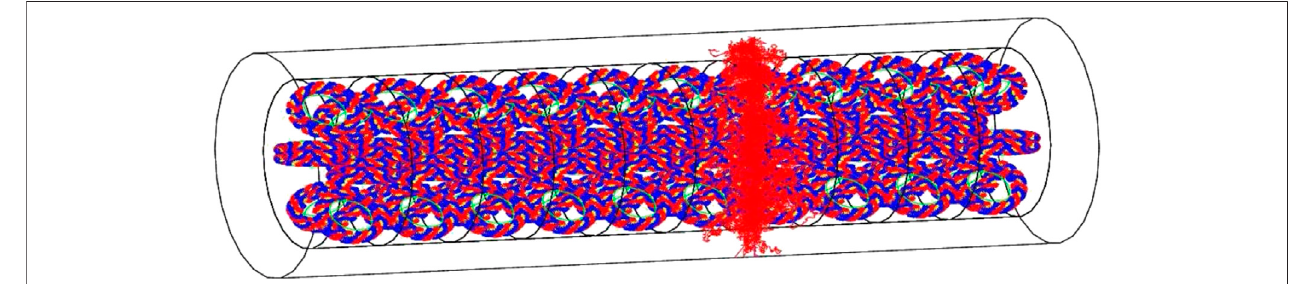
FIGURE 5 | Visualization of a whole chromatin fi ber irradiated by a single 500 keV He + particle, emitted perpendicularly to the main revolution axis of the fi ber. Individual bases are modeled as sectors of cylindrical shells, with an inner radius of 0.5 nm and an outer radius of 1.185 nm. They have a thickness of 0.33 nm. The positions of 100 pairs of bases are parameterized into a DNA helix loop.